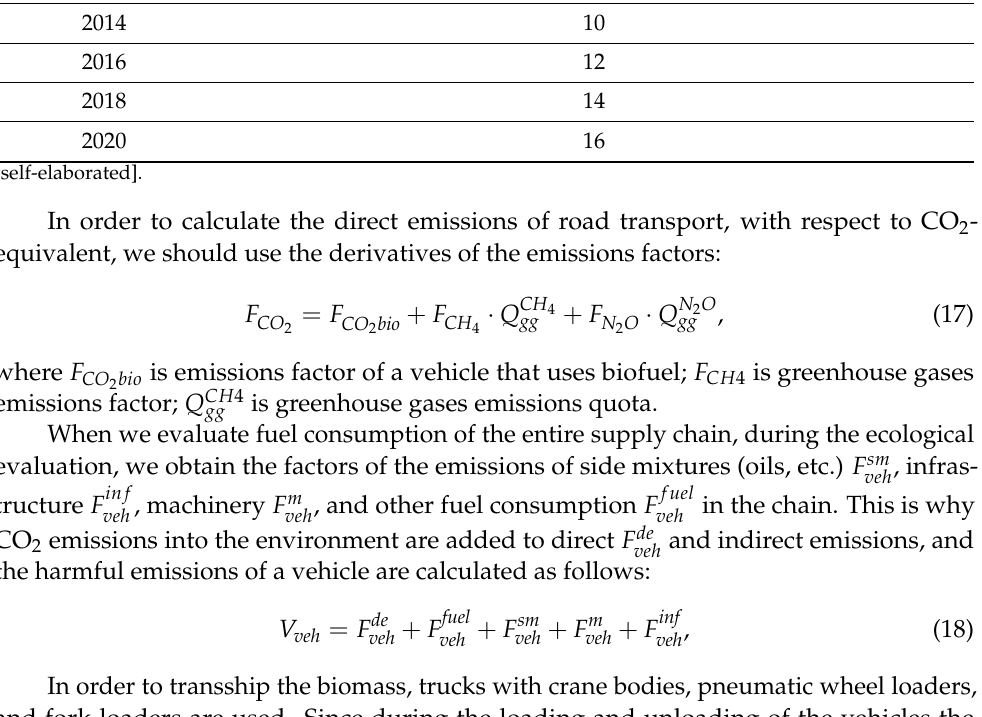
Table 1. Decrease of CO 2 emissions in percent in cases of year-to-year increases of biofuel quota in the vehicles of enterprises. Quota of CO 2 Emissions Decrease in Contrast to 2005 on Years Condition that Biofuel Quota Increases, % 2006 2 2006 4 2010 6 2012 8